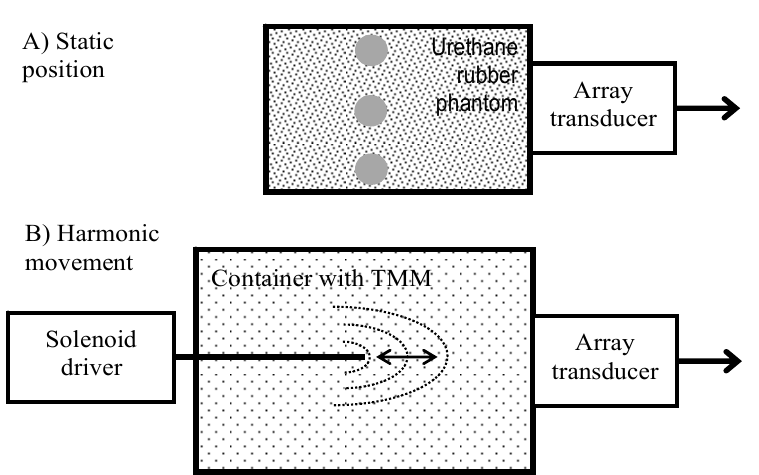
Figure 1. Structures of phantoms used in the evaluation of displacement detection system: ( A ) static structure (Model 532A); ( B ) structure with a harmonic motion phantom with displacement field (concentric dotted lines) excited in tissue-mimicking material (TMM).